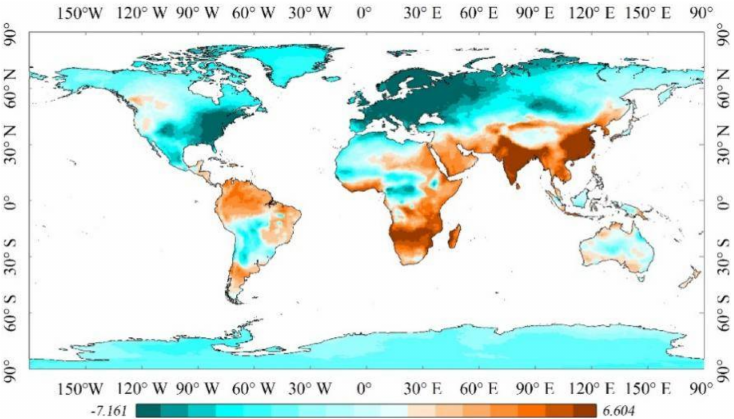
Figure 6. The MK values for the global variation of AOD values during